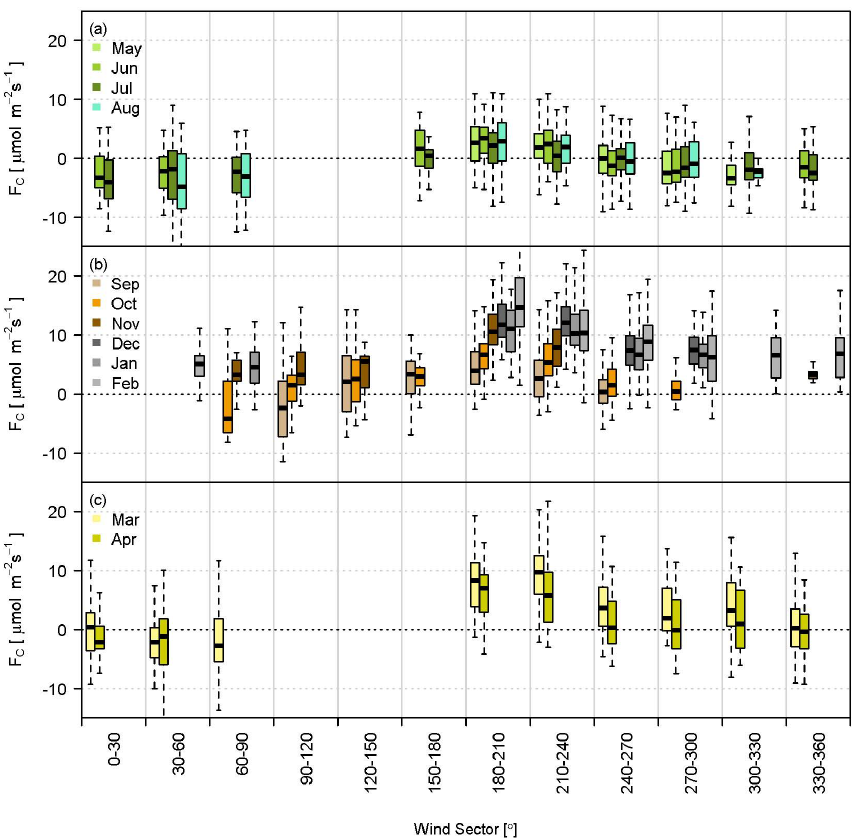
Fig. 15. Monthly boxplots of daytime ( K ↓ > 5Wm − 2 ) carbon fluxes by wind direction for (a) summer, (b) autumn–winter and (c) spring. Boxes have a minimum of 20